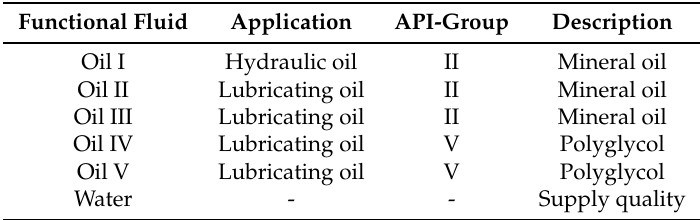
Table 2. Functional fluids classification.